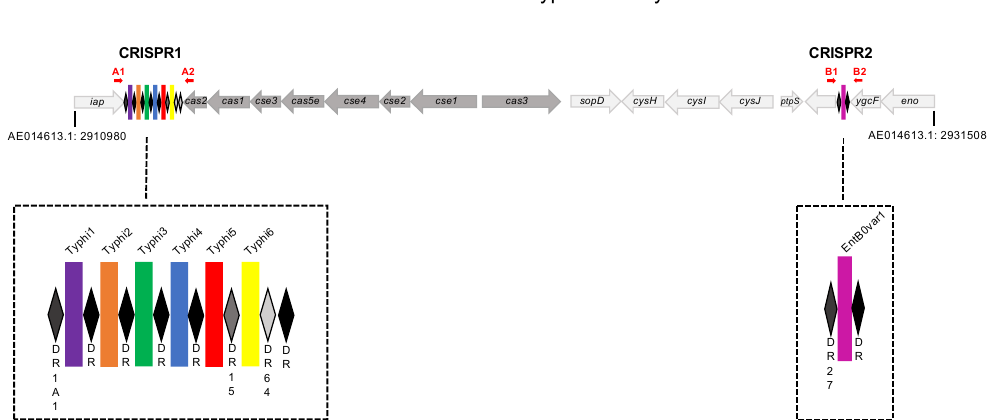
Figure 1. The CRISPR/Cas system structure of S. enterica serovar Typhi. The structure shown is that for the representative S. enterica serovar Typhi strain Ty2 (GenBank accession no. AE014613.1). Two CRISPR loci (CRISPR1 and CRISPR2) are present. The CRISPR-associated ( cas ) genes cas2 , cas1 , cse3 , cas5e , cse4 , cse2 , cse1 and cas3 genes of the I-E type are located between the CRISPR loci. Diamonds represent direct repeats (DRs), with colored rectangles indicating spacers. The primers used to extract the two CRISPR loci from genomic sequences are shown as red horizontal arrows. The coordinates of the region (based on AE014613.1) are indicated.